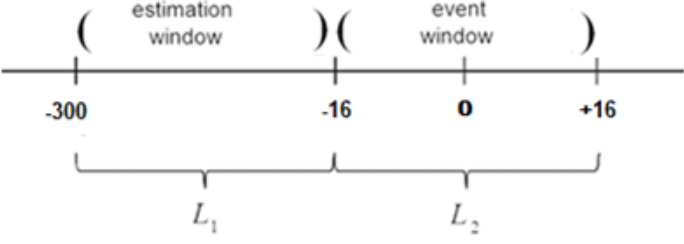
Figure 2. Estimation window (L1) for the period of time preceding the event (L2).